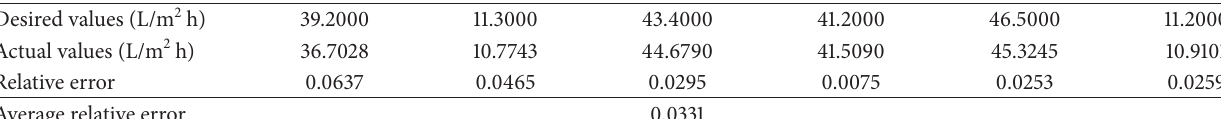
Table 3: Relative error of the prediction of GA-BP